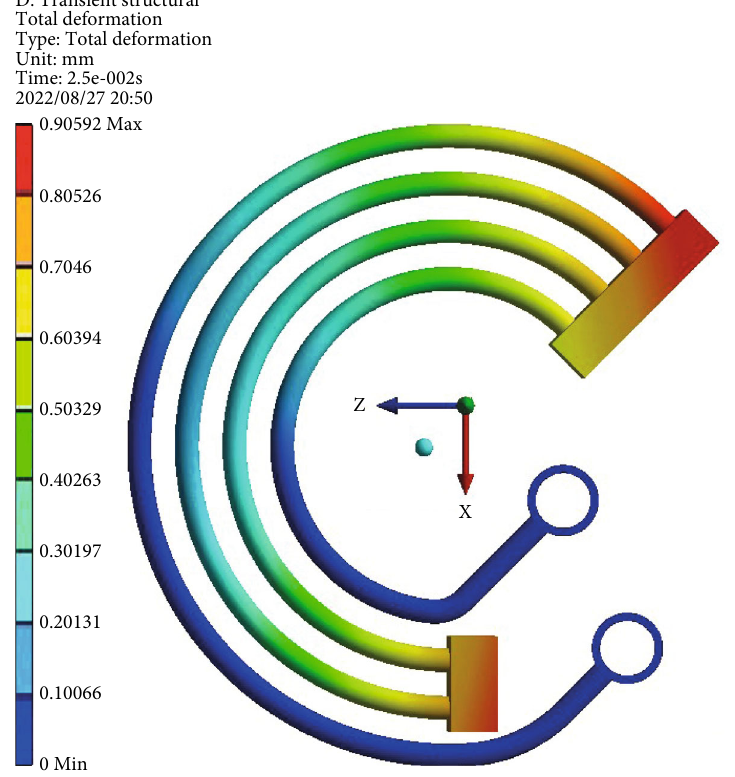
= v = 0 : 5 m/s . shell tube